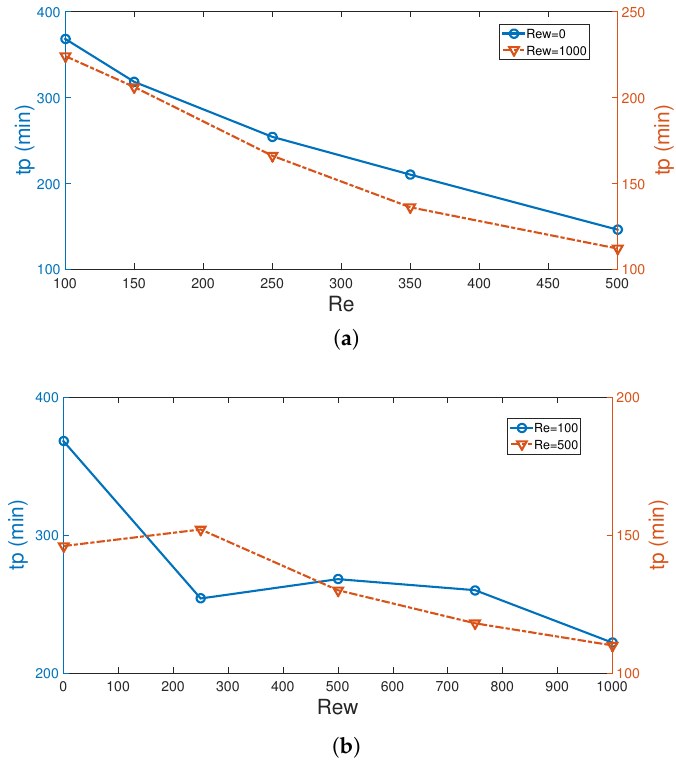
Figure 9. Complete phase transition time (tp in minutes) with varying Re at the lowest and highest Rew ( a ) and with varying Rew at the lowest and highest Re ( b ) ( di = 0.25 L 1, L 0 = 0.6 L 1, yp = 0.1 H, and NC = 0.02).